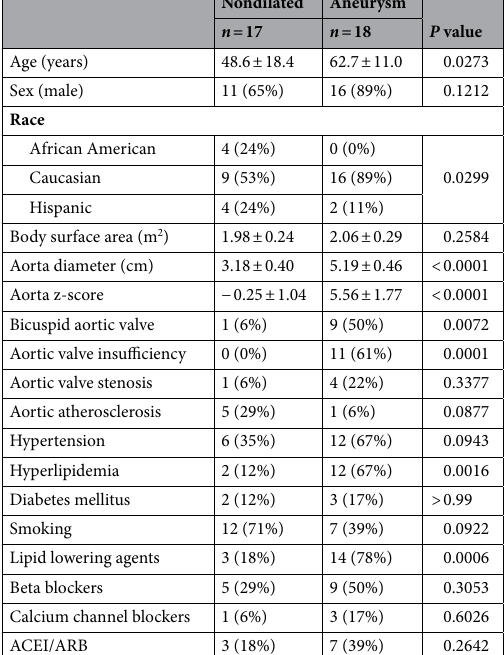
Table 1. Subject characteristics. Ascending aorta specimens were procured from organ donors (nondilated) and patients undergoing aortic aneurysm repair (aneurysm). Continuous variables are represented as mean ± SD and categorical variables are represented as number of subjects and percentage of total subjects. Comparisons of continuous variables are by Mann–Whitney test and of categorical variables by Fisher’s